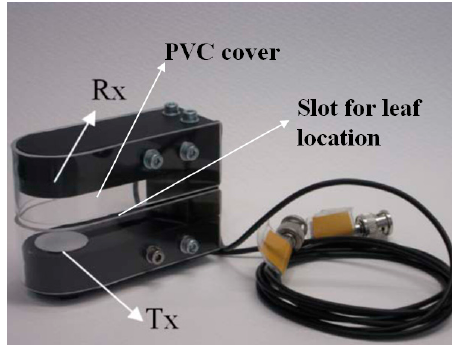
Figure 7. Picture of the mechanical holder for sensors and leaf.